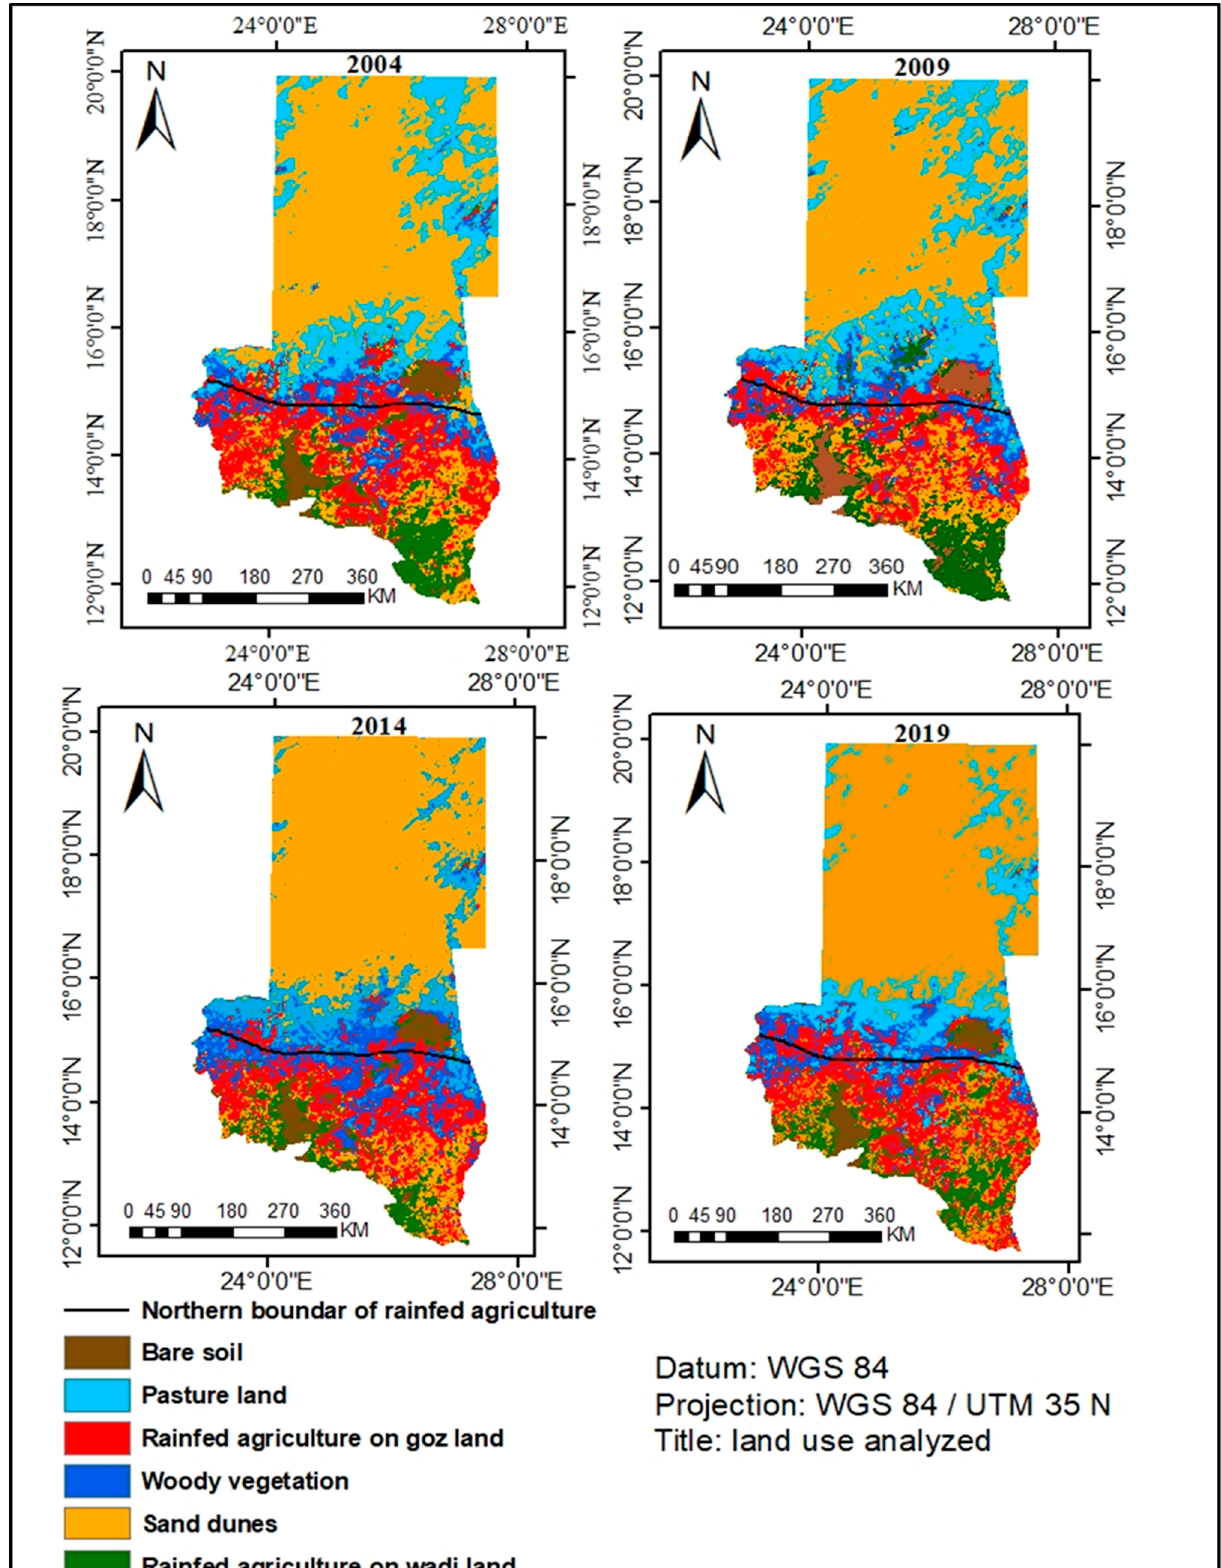
Figure 3. Spatial distribution of the rainfed agriculture and other LULC classes in 2004–2009 and 2014–2019. The classification was obtained using Landsat-7 ETM+, Landsat-8 OLI, and random forest classifier.